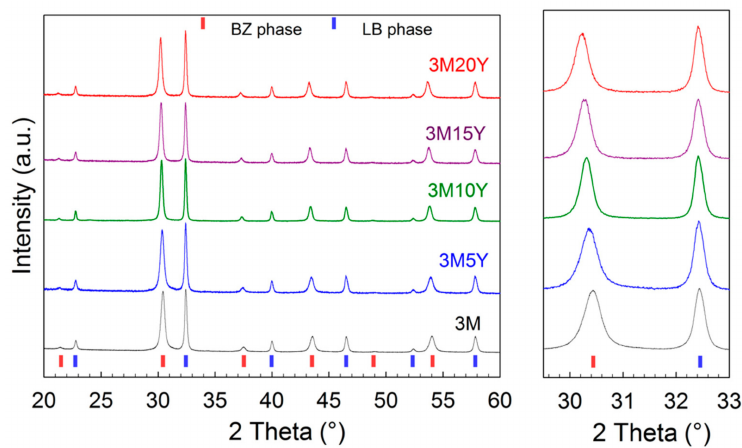
Figure 3. XRD patterns at room temperature of the composites with nominal composition of 0.6 La 0.5 Ba 0.5 Co 1/3 Mn 1/3 Fe 1/3 O 3 − δ -0.4 BaZr 1 − z Y z O 3 − δ formed at 900 ◦ C for 3M and 3M5Y and 1000 ◦ C for 3M10Y, 3M15Y, and 3M20Y. BZ and LB stand for barium zirconate-based phase BaZr 1 − z Y z O 3 − δ and